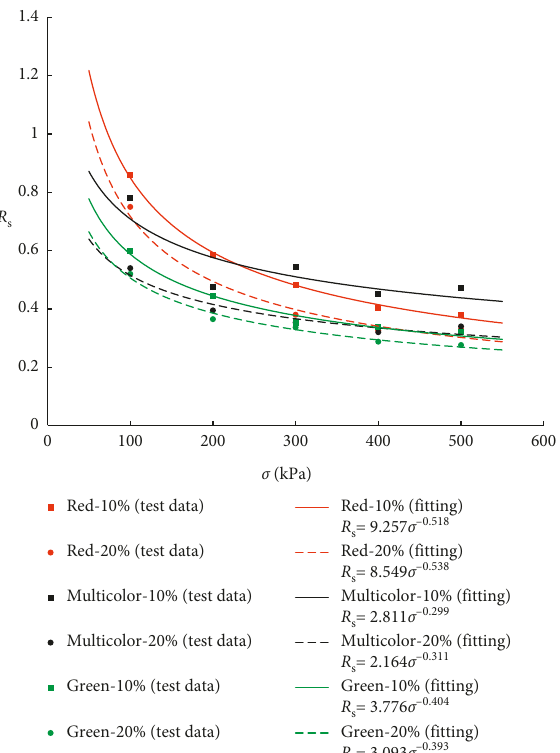
Figure 14: Fitting curves and fitting equations of R